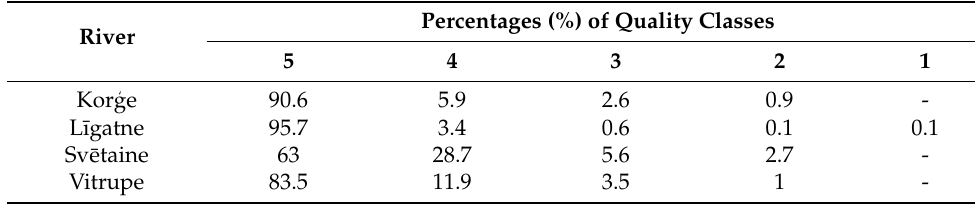
Table 3. Values of erosion protection for each river, according to USLE analysis.